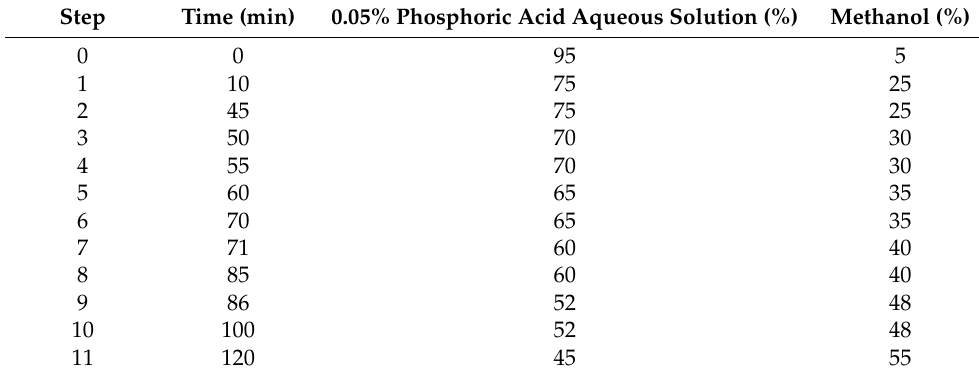
Table 4. The chromatography conditions of HPLC (1 mL/min and 25 ◦ C).